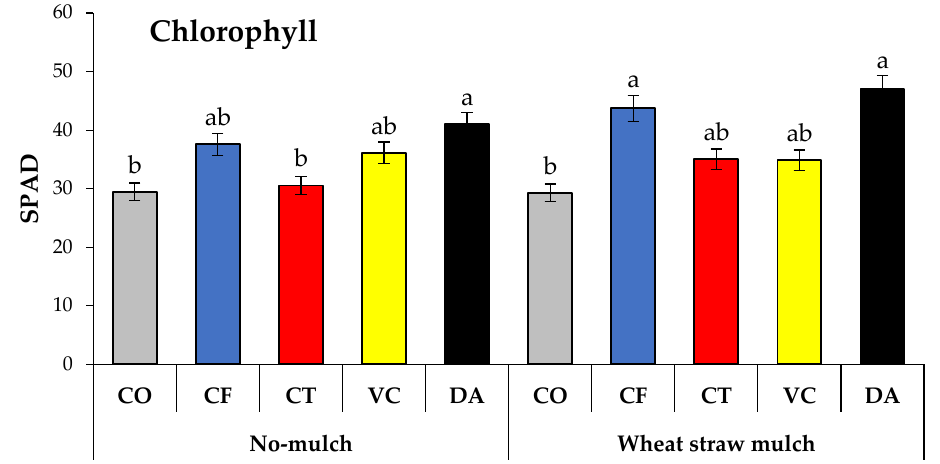
Figure 1. Effect of organic amendments and mulching system on chlorophyll (SPAD) in the leaves of squash plants. CO = Control (without fertilization), CF = Recommended mineral fertilization (112 kg N ha −1 + 50 kg P 2 O 5 + 75 kg K 2 O ha −1 ), CT = Compost (7.5 t ha −1 ), VC = Vermicompost (7.5 t ha −1 ), DA = Dry Azolla pinnata (3.75 t ha − 1 ). Different letters indicate significant differences according to Duncan’s multiple range test at p ≤ 0.05. Data are means of three replicates ± SE.